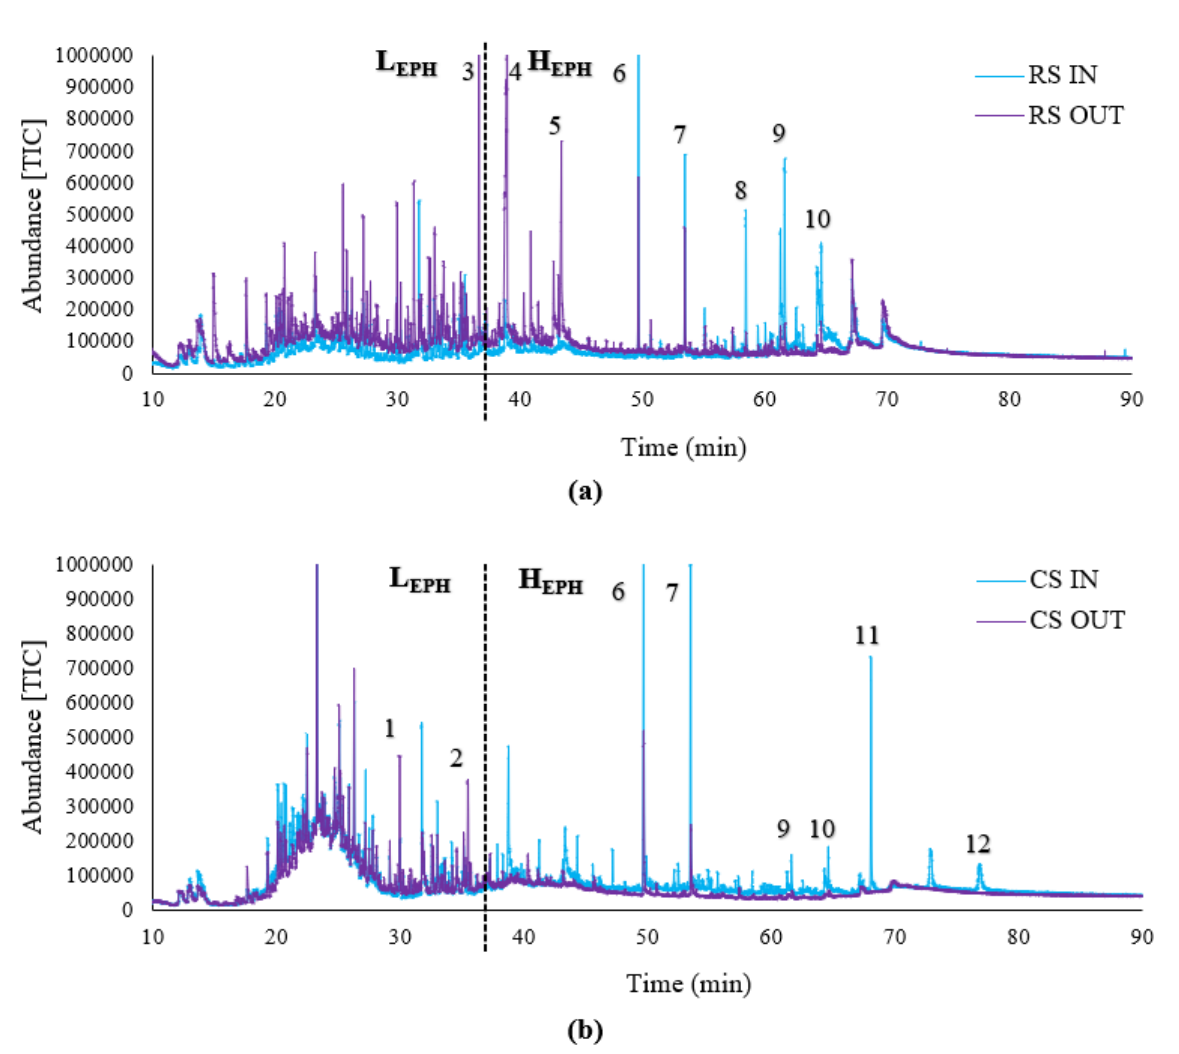
Table 2 . EPH fractions UCM area ratios for RS and CS before (IN) and after (OUT) AD.